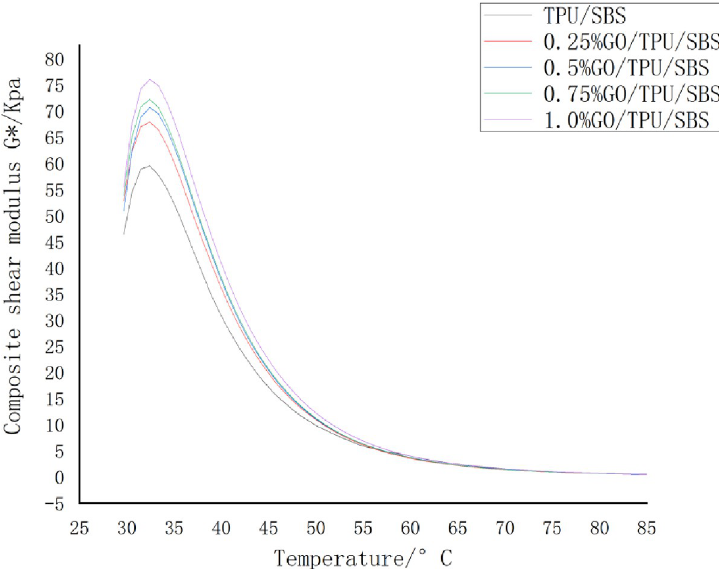
Fig 6. The effect of temperature on the composite shear modulus of the GO/TPU/SBS-modified asphalt.